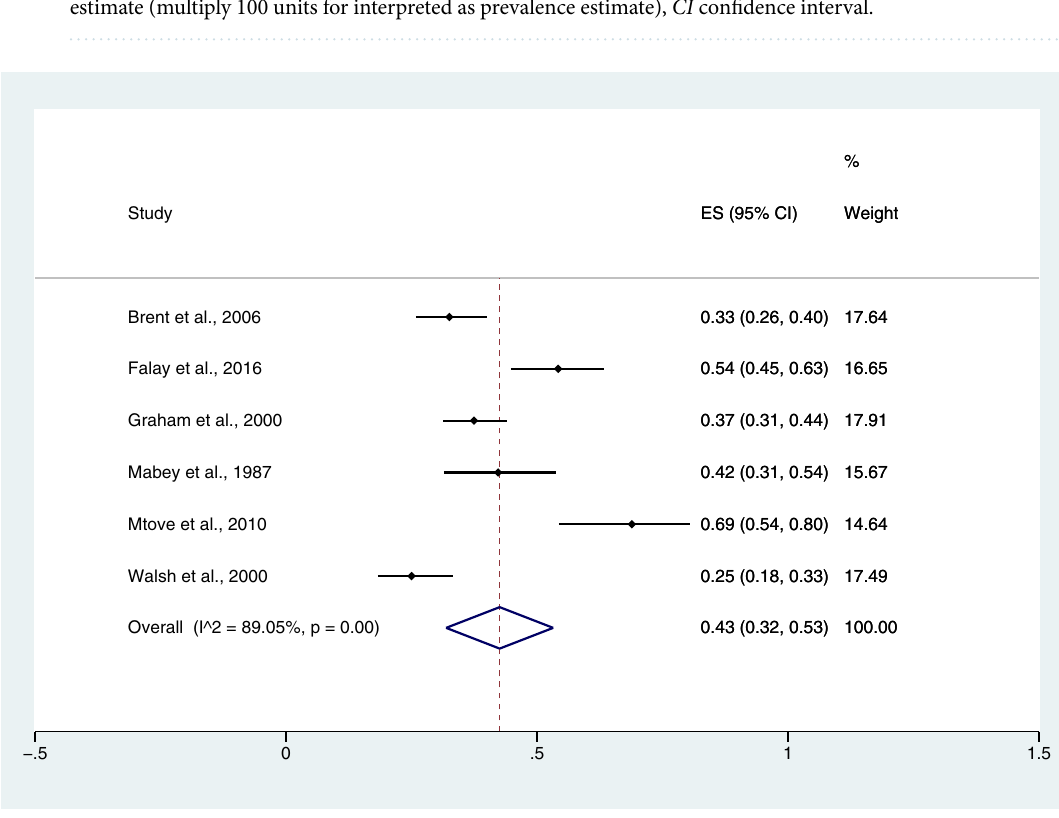
Figure 23. Pooled prevalence of malaria infection among patients with NTS. ES proportion estimate (multiply 100 units for interpreted as prevalence estimate), CI confidence